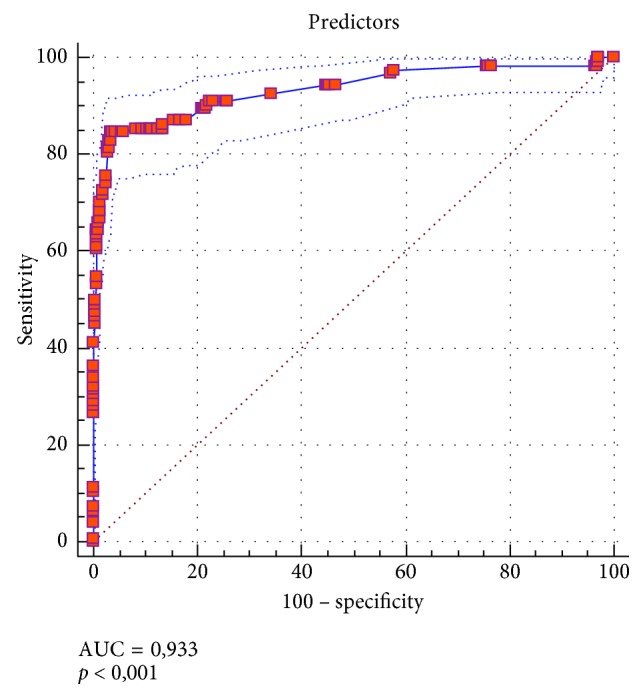
Performance of the model for predicting in-hospital mortality.